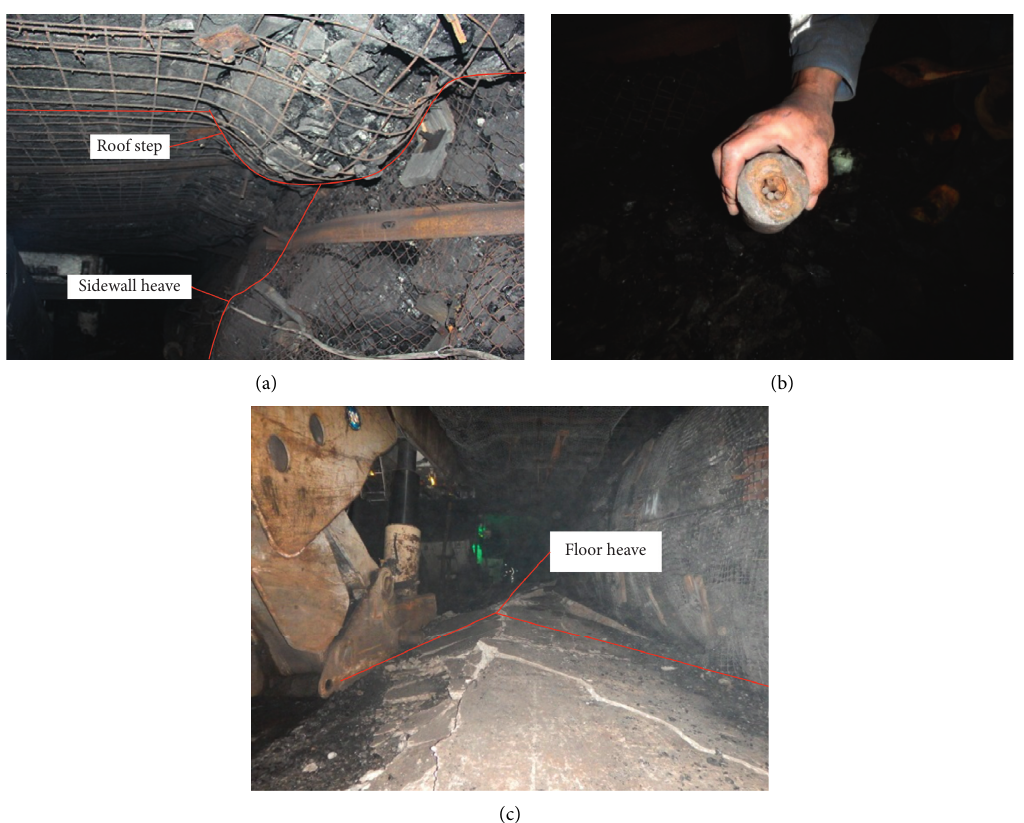
Figure 9: Deformation and failure of surrounding rock in the 42,106 return air roadway. (a) Floor and sides’ deformation. (b) Broken anchor cable. (c) Floor